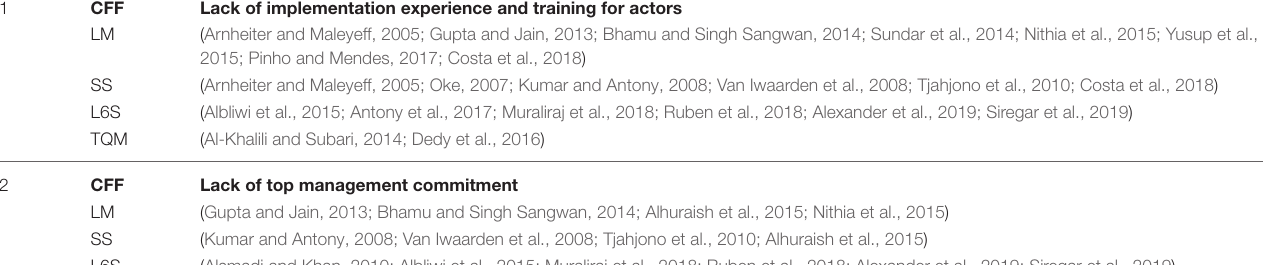
TABLE 4 | Top 10 of CFF identified in the articles